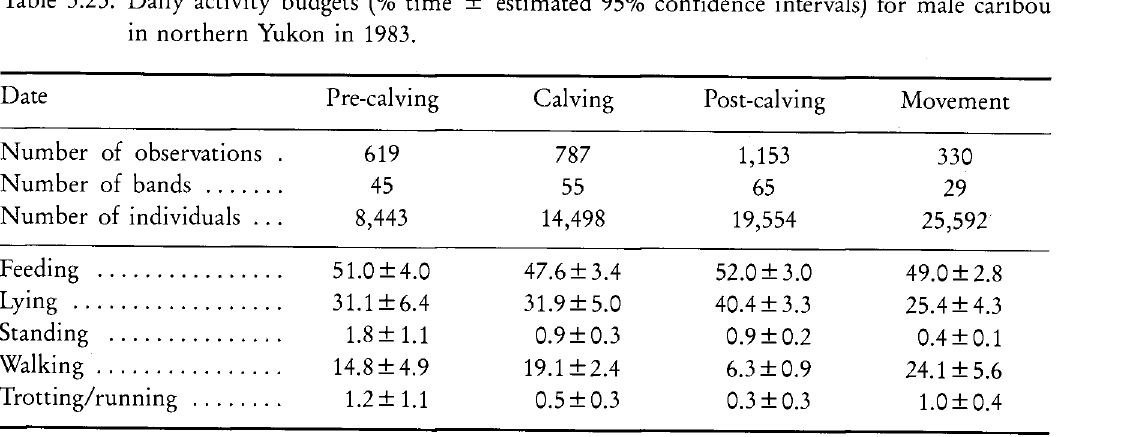
Table 3.26. Length (minutes) of active and resting periods (x ± SE) for male caribou in northern Yukon in 1983. (Samples